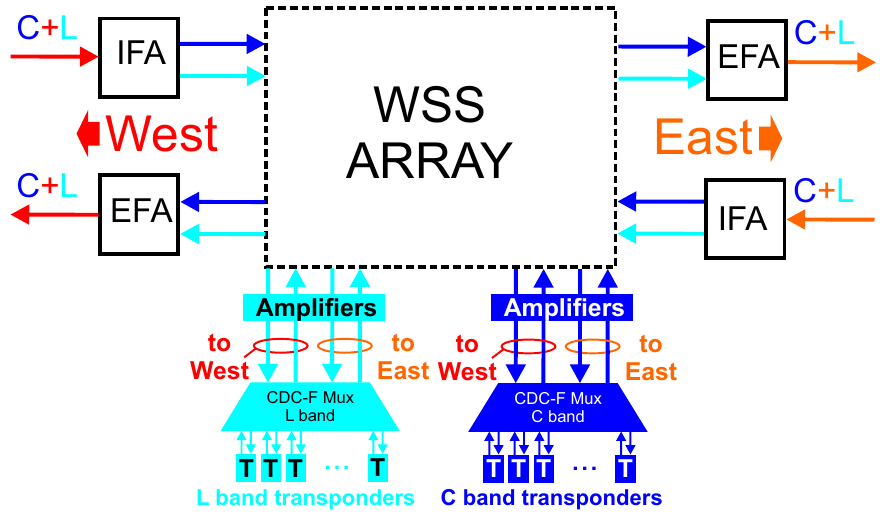
Figure 1. Schematic diagram of a two-dimensional colourless, directionless, contentionless, flexible grid (CDC-F) ROADM used in C + L WDM systems; WSS—Wavelength Selective Switch, IFA—Ingress Fiber Amplifier, EFA—Egress Fiber